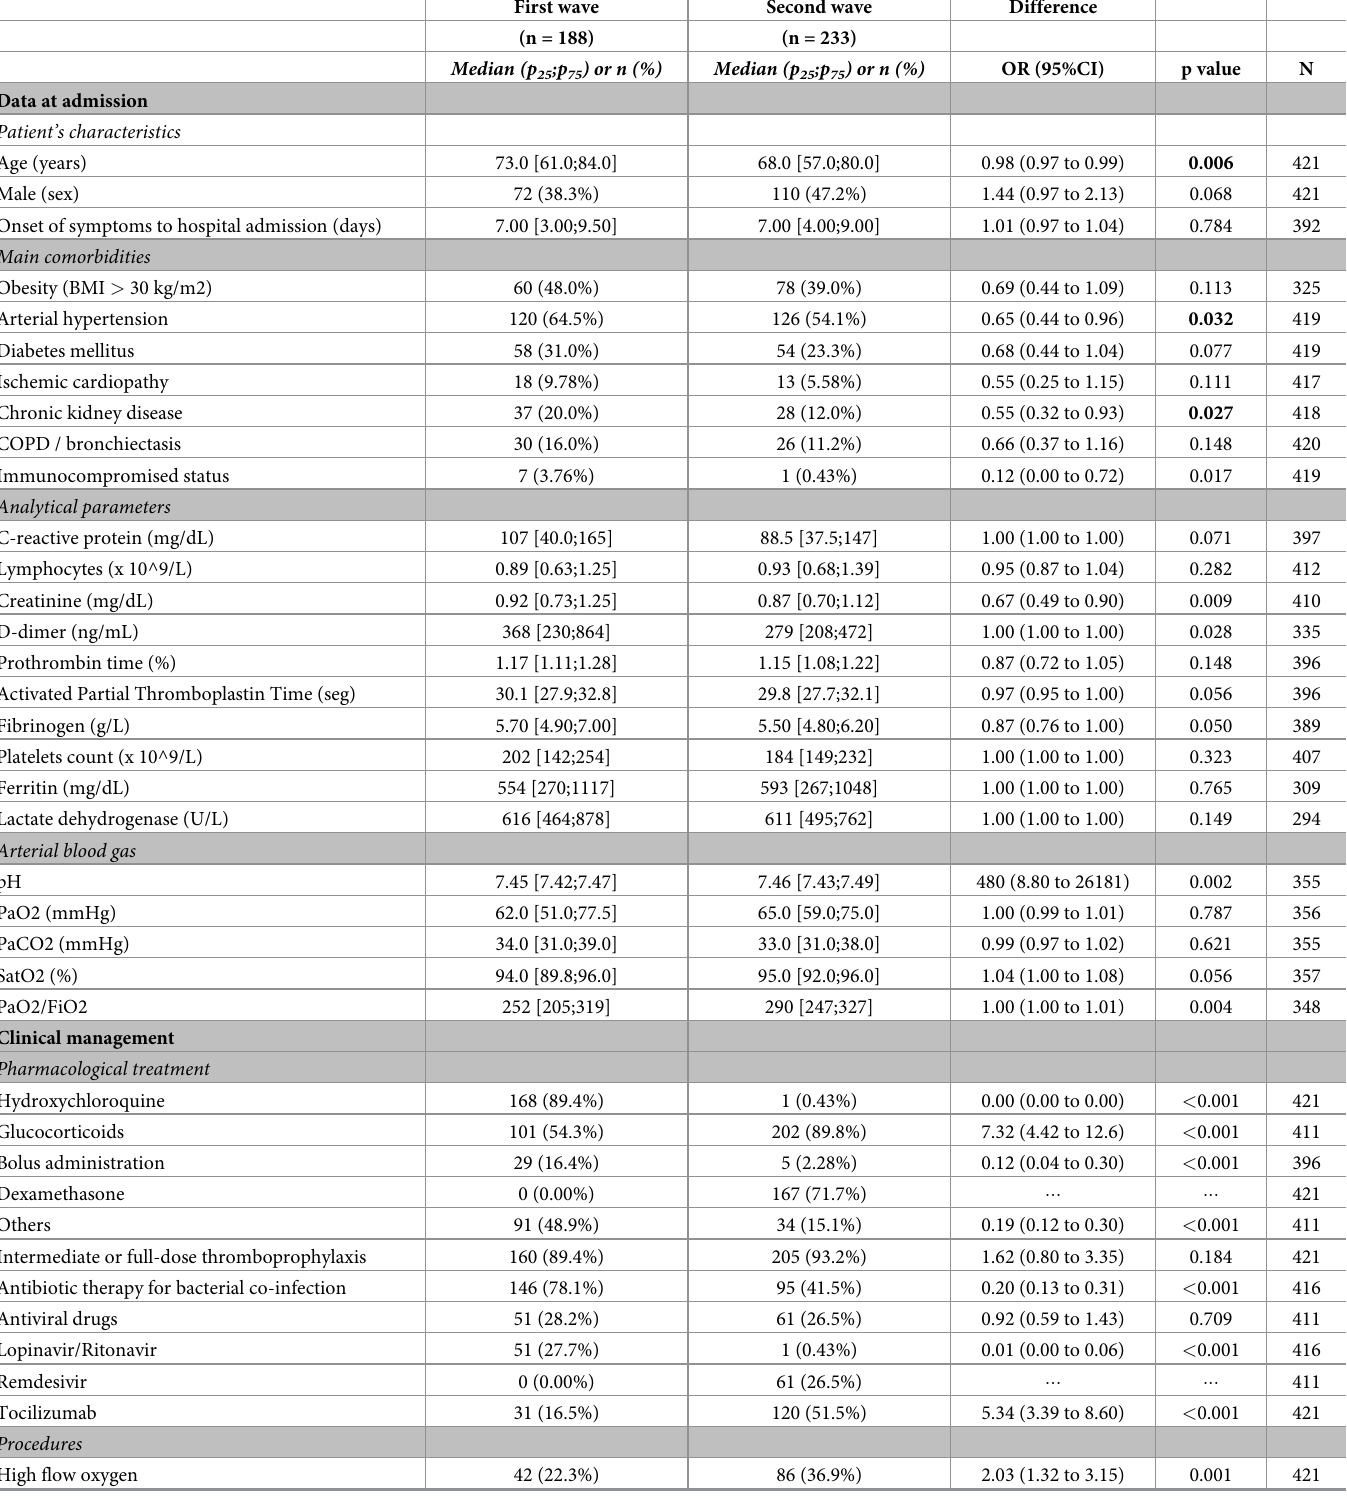
Table 1. Clinical and outcome comparison between COVID-19 hospitalized patients admitted during the first (n = 188) and the second (n = 233) COVID-19